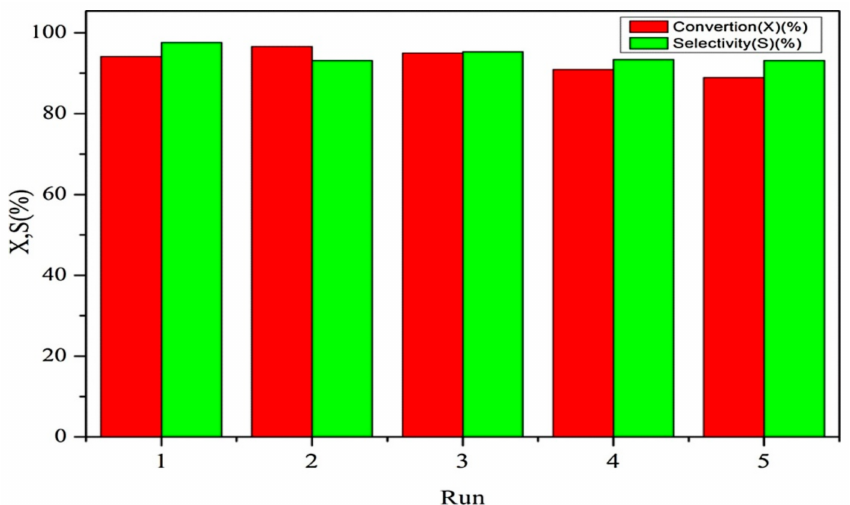
Figure 19. Reusability studies of MIL-101-IMBr-6. Reproduced with permission Ref. [160]. Copyright 2018